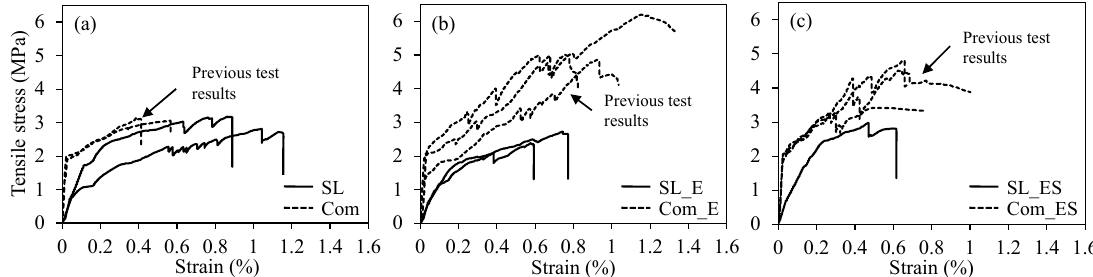
Figure 20. Tensile stress–strain relationship of TRM coupons subjected to sustained load: ( a ) coupons without surface treatment; ( b ) coupons impregnated by epoxy; ( c ) coupons coated with aluminum oxide powder after epoxy impregnation.